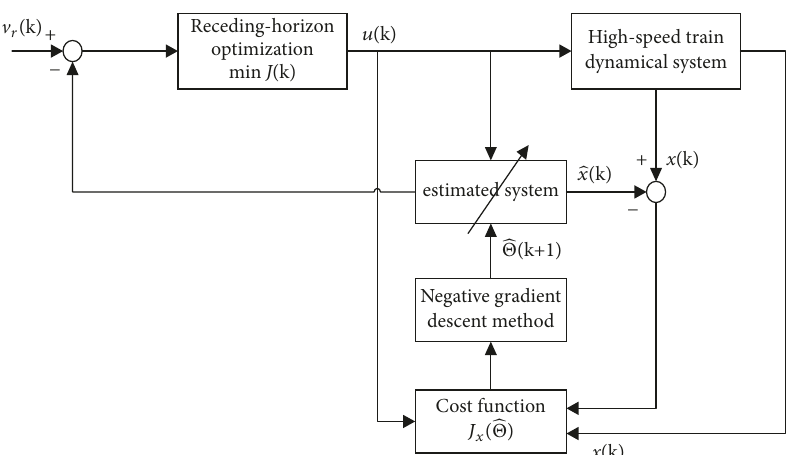
Figure 2: Adaptive model predictive control